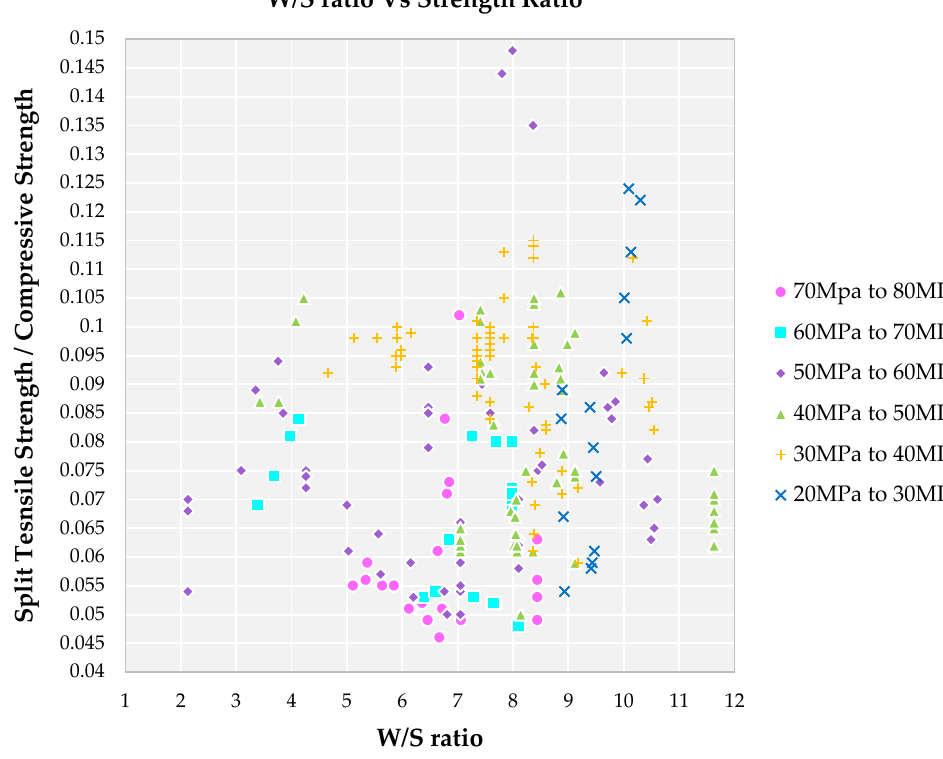
Figure 9. Impact of W/S ratio on split tensile strength to compressive strength for different grades of SCC concrete with recycled aggregate according to literature.